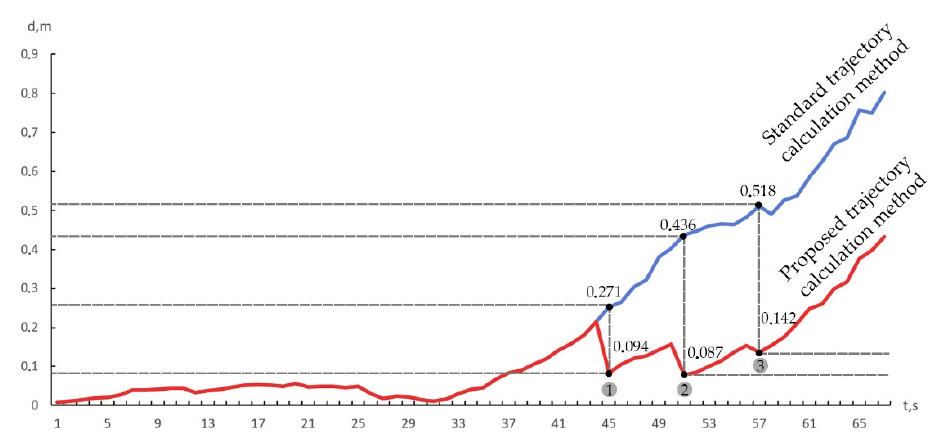
Figure 10. Evaluation of the effectiveness of the proposed technique: a comparison of the “standard” technique for calculating the AUV trajectory with the proposed technique. technique for calculating the AUV trajectory with the proposed